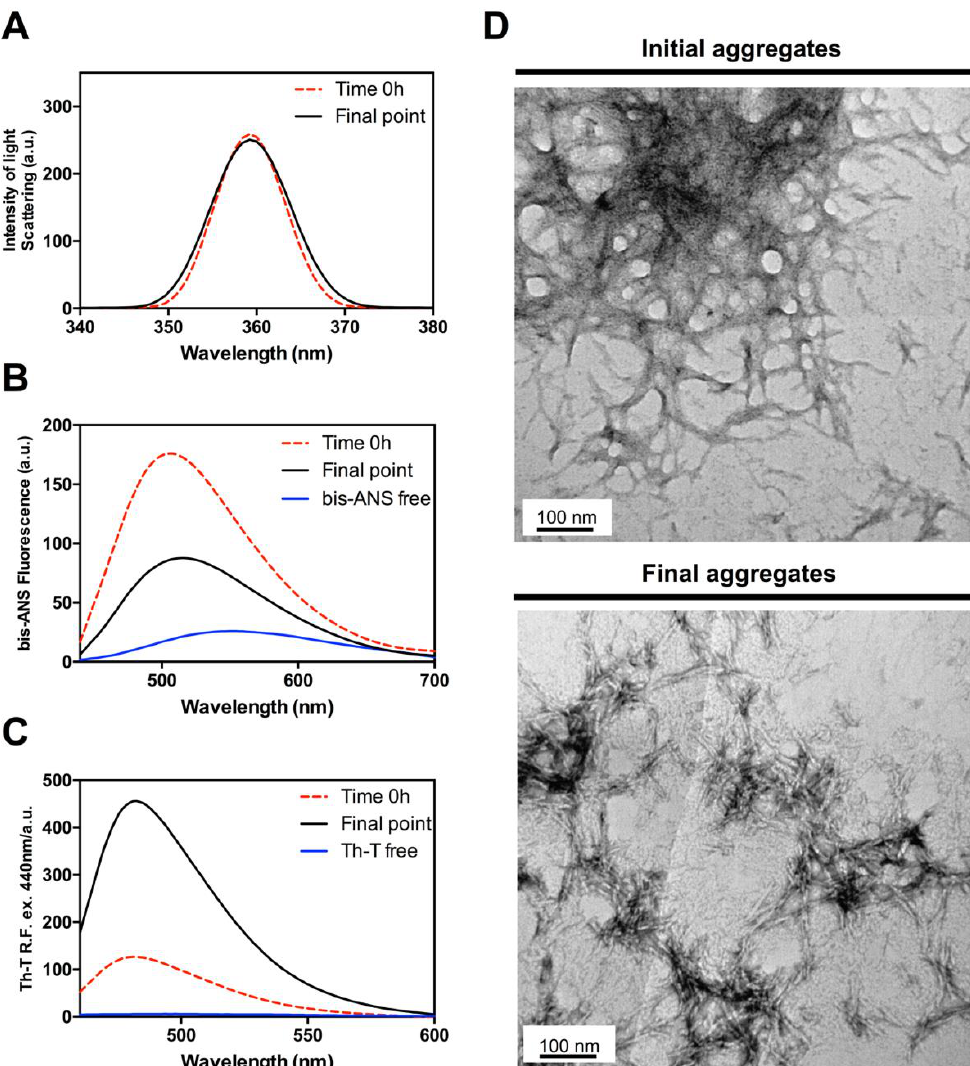
Figure 6. Evolution of the amyloid core of Hsf1 from initial non-ordered aggregates into mature amyloid fibrils. ( A ) Light scattering; ( B ) Bis-ANS fluorescence emission; ( C ) ThT fluorescence emission; ( D ) representative TEM images of initial and final Hsf1 peptide aggregates. The final point corresponds to 120 h.